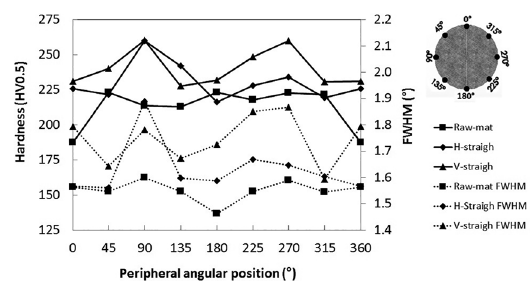
Figure 8. Hardness distribution (HV0.5) provided by an average of three points in each position measured as close as possible from the surface and FWHM in the peripheral positions of the bar both measured from 50 µm from the surface.